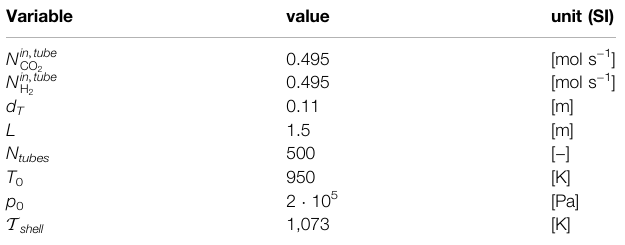
TABLE 3| Listofdesignparametersandnominal operating